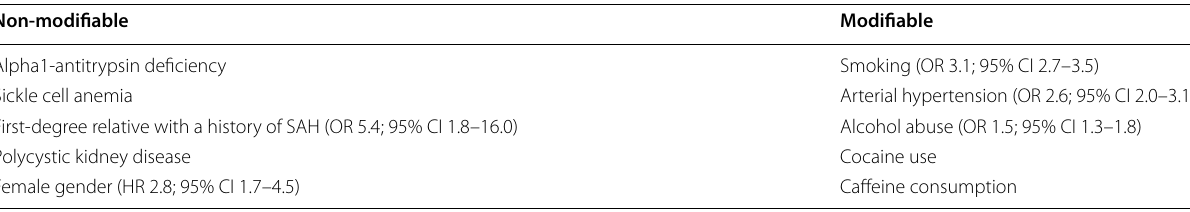
Table 1 Risk factors for the development of subarachnoid hemorrhage [6–11]